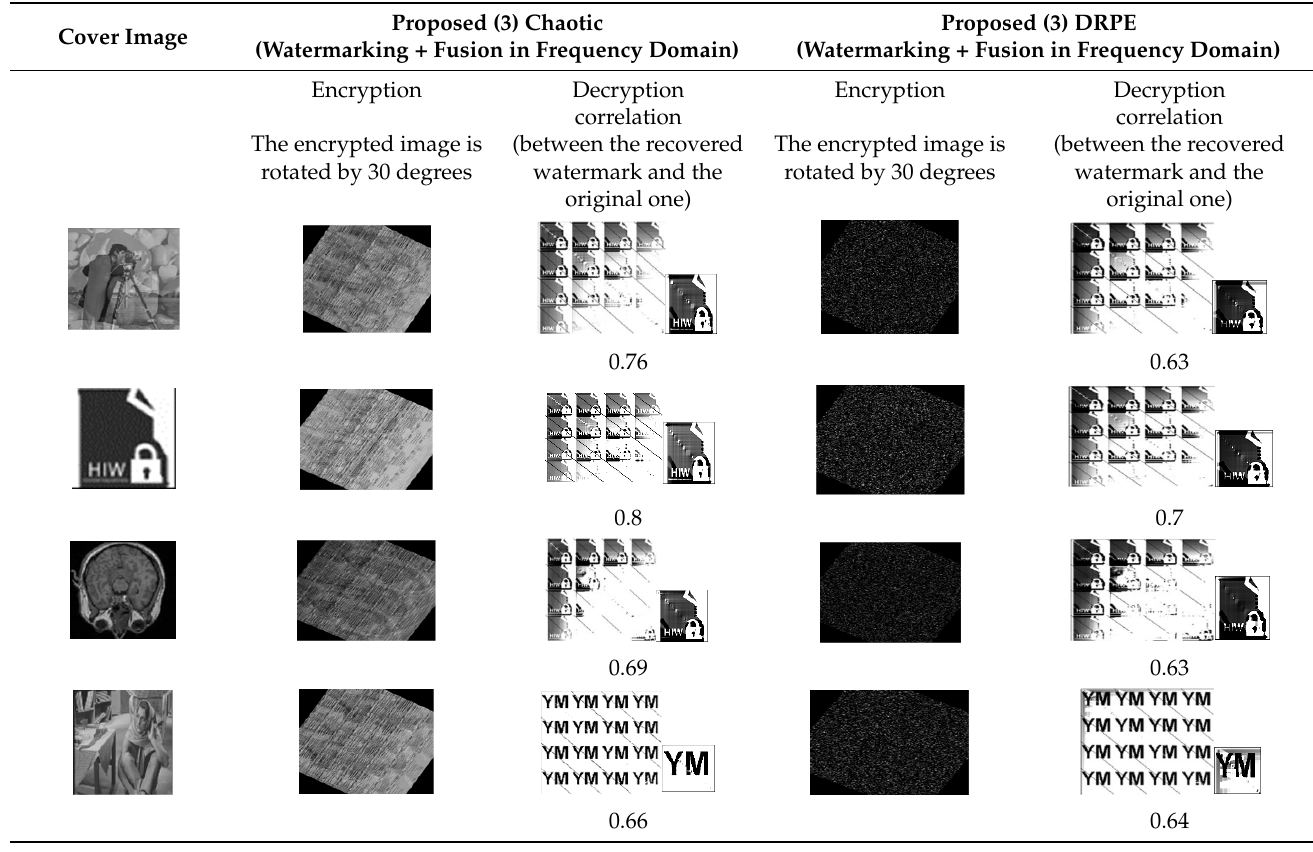
Table 8. Rotated images and corresponding extracted watermarks for the third proposed technique.